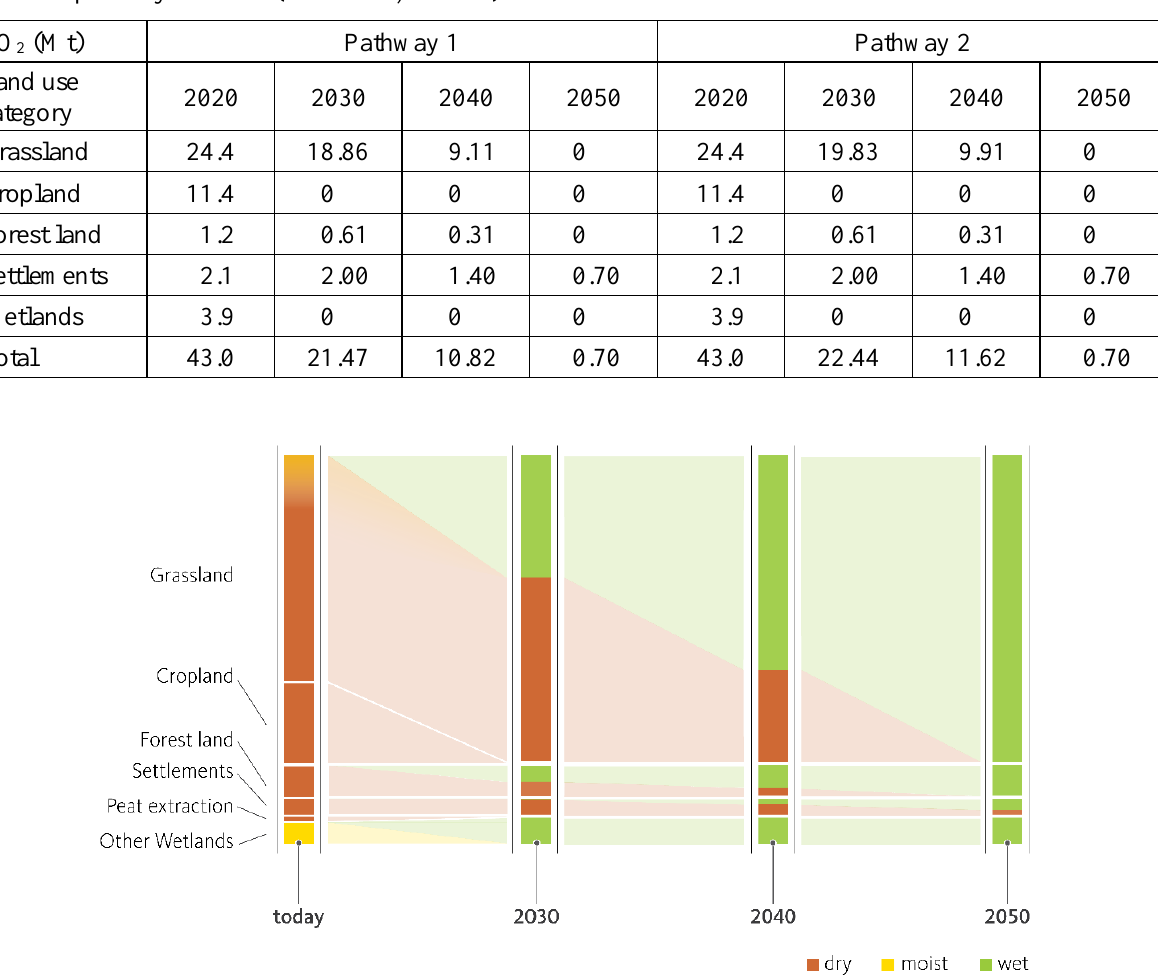
Figure 3. Net zero CO 2 emission pathway for organic soils in Germany visualising transformation by land use category (in % of total peatland area) over the period 2020–2050 and excluding an intermediate ‘moist’ stage (pathway 2). Dry=deep-drained, wet=undrained/rewetted (mean annual water table at the soil